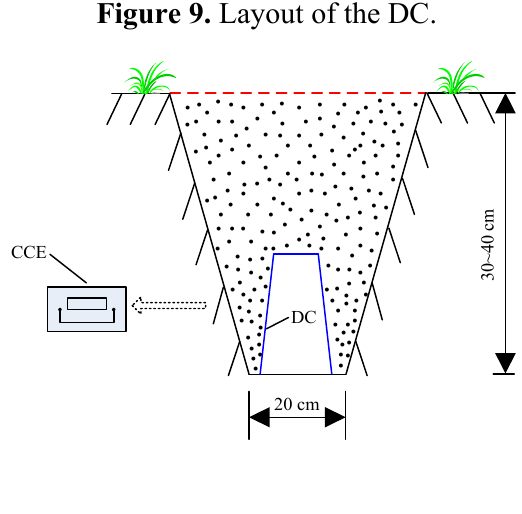
Figure 9. Layout of the DC.